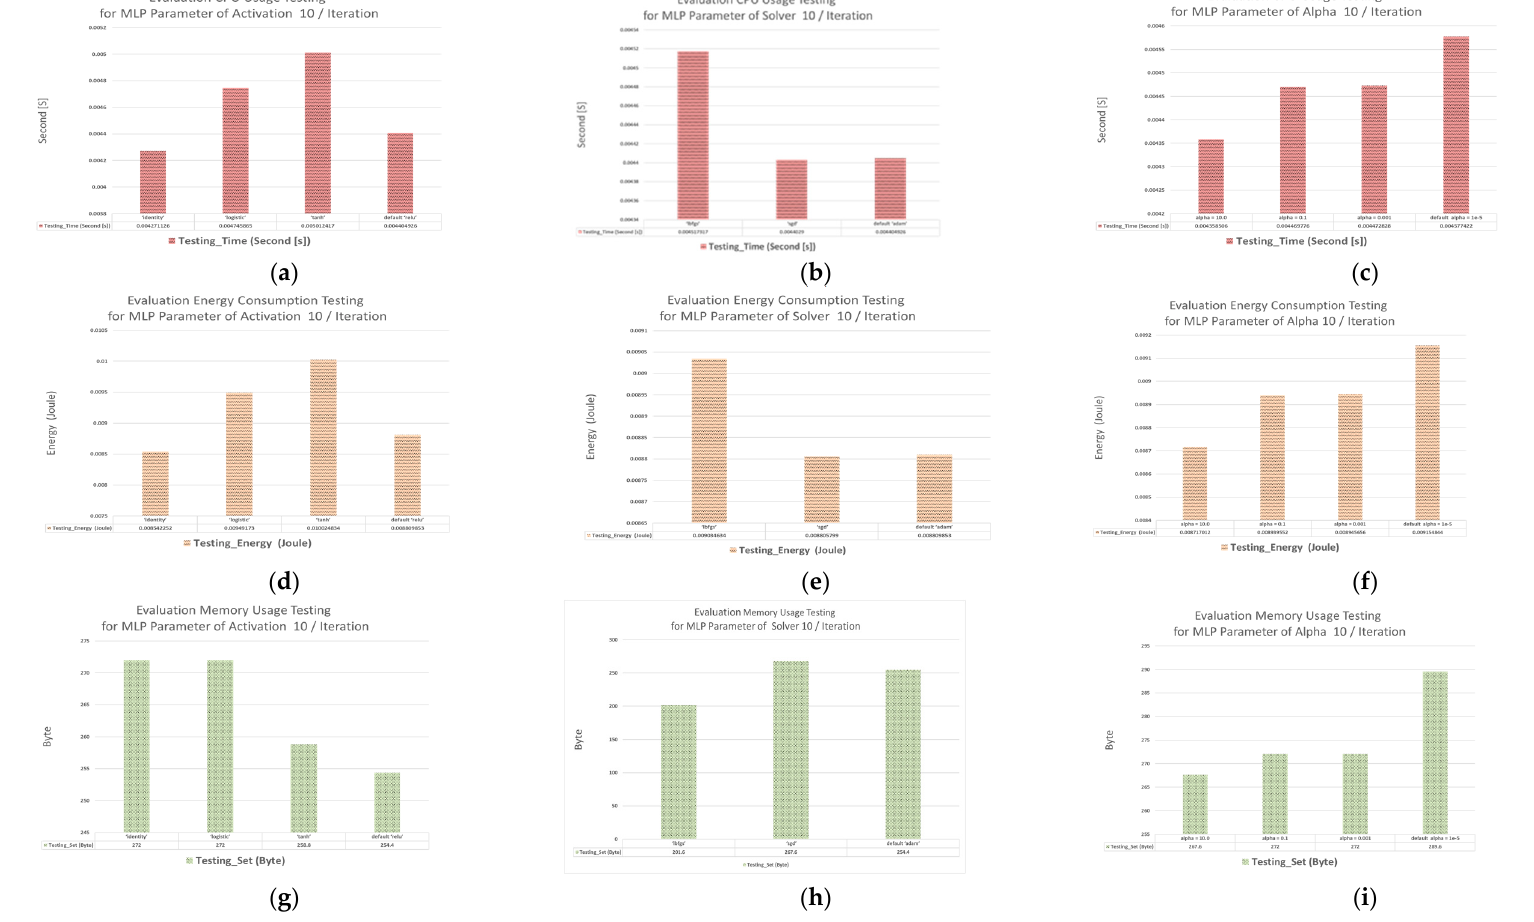
Figure 11. Evaluation lightweight of MLP parameter 10/Iteration: ( a ) Evaluation CPU Usage Testing for Activation; ( b ) Evaluation CPU Usage Testing for Solver; ( c ) Evaluation CPU Usage Testing for Alpha; ( d ) Evaluation Energy Consumption Testing for Activation; ( e ) Evaluation Energy Consumption Testing for Solver; ( f ) Evaluation Energy Consumption Testing for Alpha; ( g ) Evaluation Memory Usage Testing for Activation; ( h ) Evaluation Memory Usage Testing for Solver; ( i ) Evaluation Memory Usage Testing for Alpha.